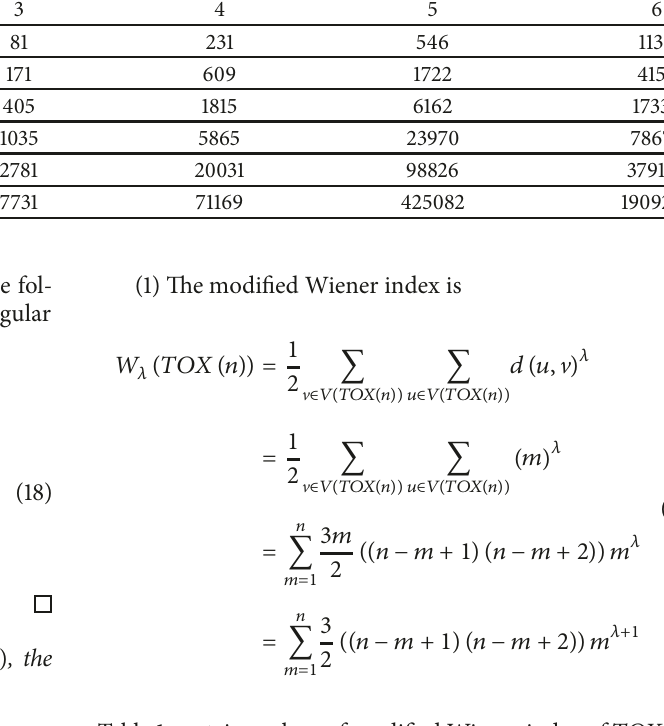
Table 1 contains values of modified Wiener index of 𝑇𝑂𝑋 for different values of 𝑛 and 𝜆 .